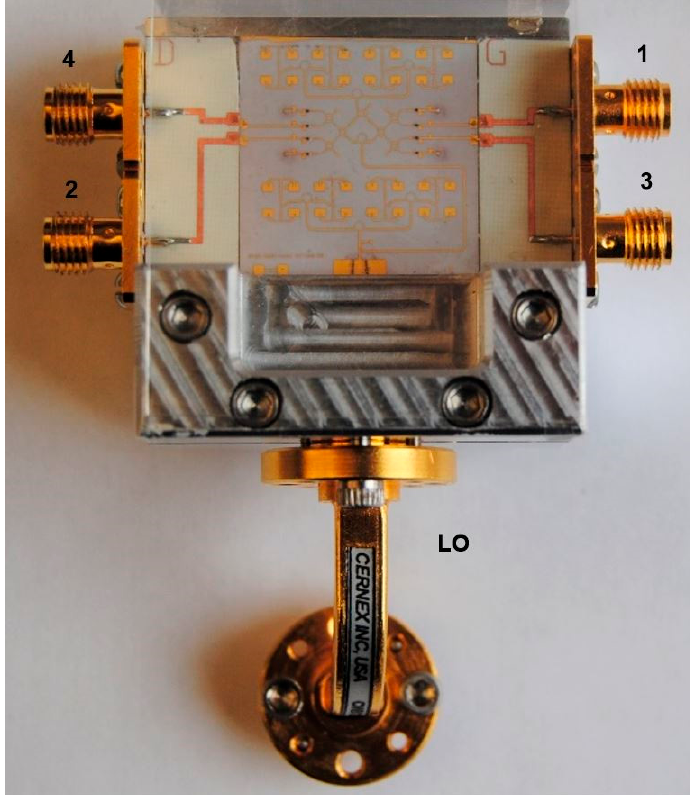
Figure 15. V-band multi-port radar sensor in aluminum fixture with standard WR-12 flange and SMA connectors.